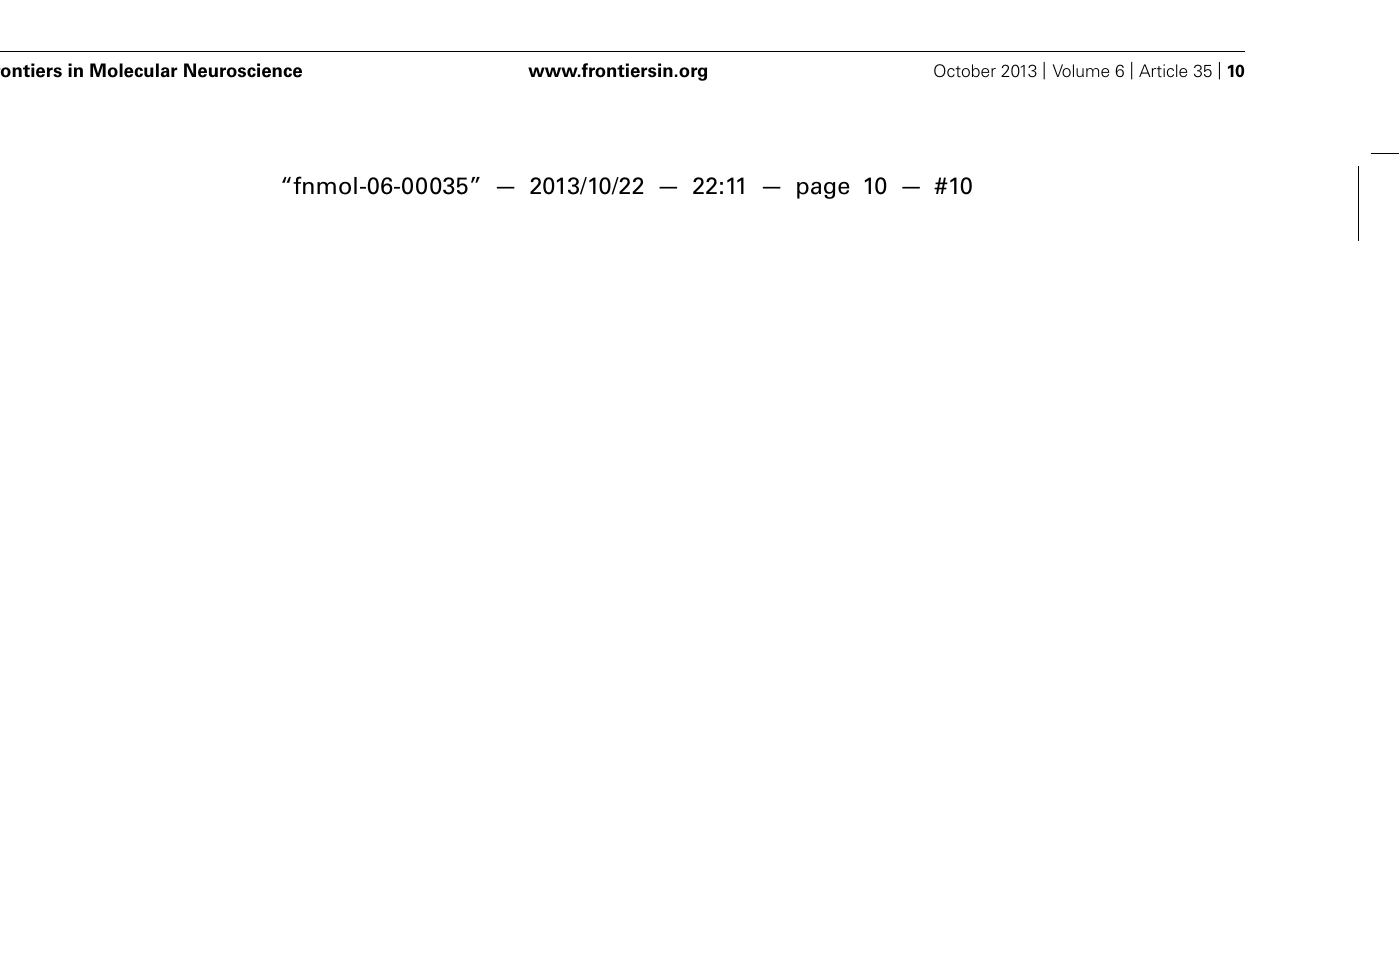
FIGURE 5 | Knockdown of Kremen1 increases neurite outgrowth. (A) Neurite outgrowth in Kremen1 siRNA and scrambled siRNA treated DRG neurons was detected by TUJ immunostaining. Representative images show that Kremen1 siRNA significantly decreased Kremen1 expression level, which was accompanied by an increase of axon outgrowth. Scale bar: 20 μ m. As the quantification performed in miR-431